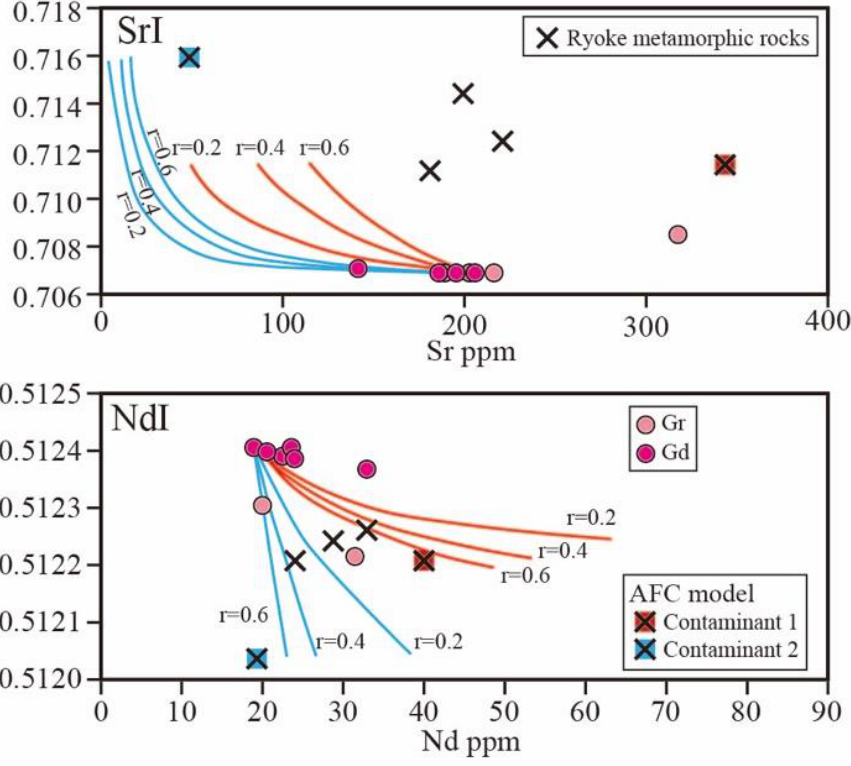
Figure 11. The results of assimilation and fractional crystallization (AFC) model. The granodiorite and the Ryoke pelitic gneiss correspond to a parental magma and contaminants, respectively. The “r” values indicate the ratio of assimilation/fractionation. The blue and red lines indicate the calculated AFC trends using the different contaminants. In Sr–SrI diagram, the granite deviates significantly from these lines. Therefore, the granite cannot be reproduced by the AFC process. See the text for detailed explanation.